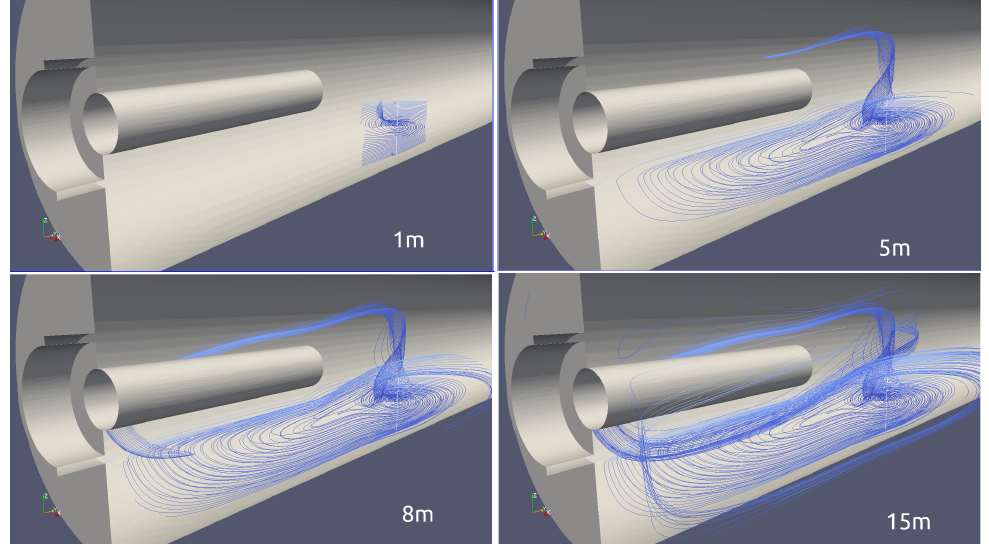
Figure 6. development of the vortex stretching with increasing streamline